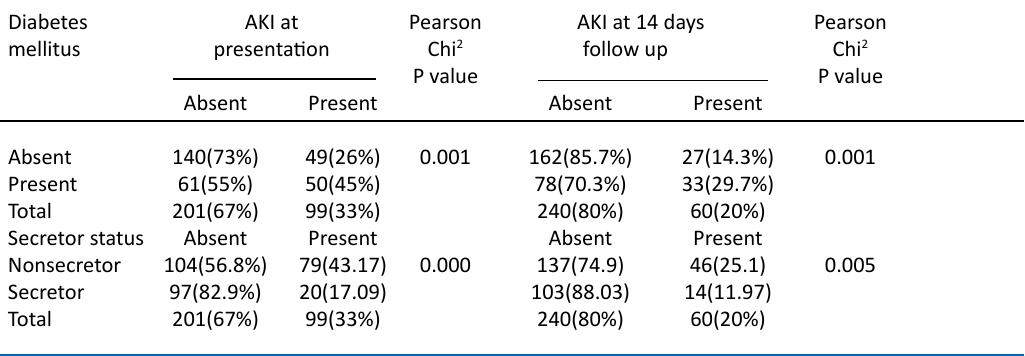
Table 4. Association of Diabetic and Secretor status of the patient with AKI at presentation and at 14 days follow up Diabetes AKI at Pearson AKI at 14 days Pearson mellitus presentation Chi 2 follow